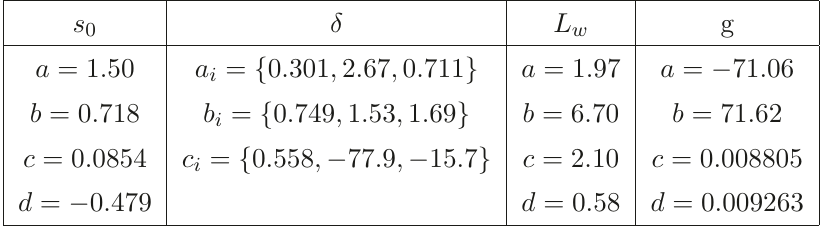
Table 3 . List of parameters involved in curve fitting the bounce solution (need to fix sig figs